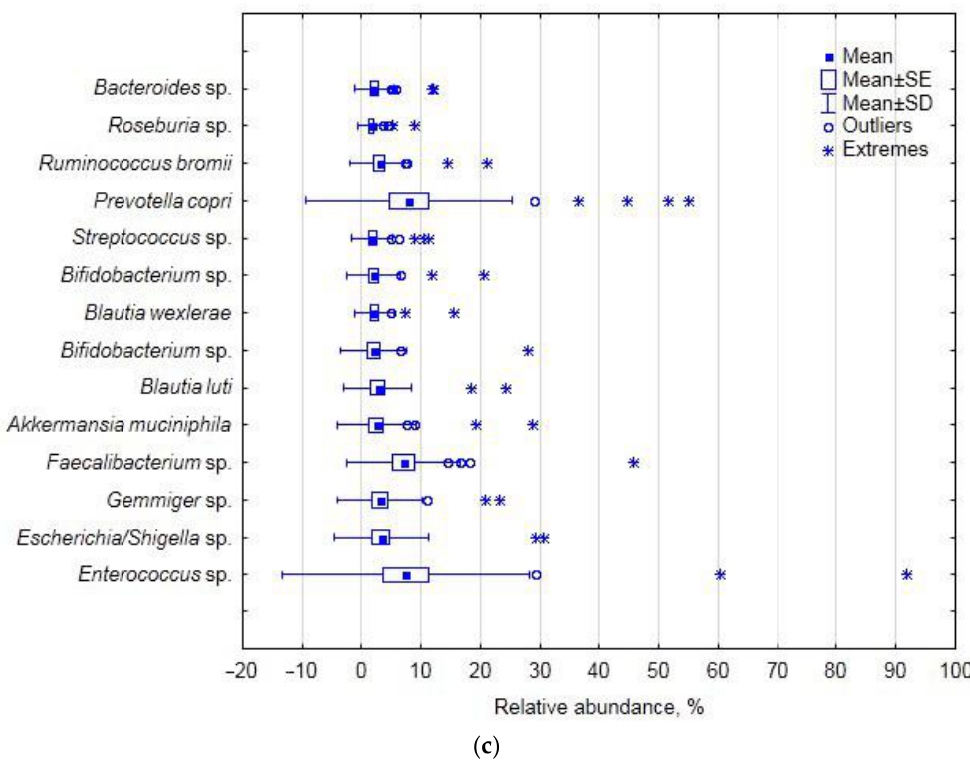
Figure 1. Relative abundance of the dominant bacterial taxa in females with gallstone disease (GSD) before cholecystectomy (CCE): ( a ) phyla, ( b ) families, ( c ) operational taxonomic units (OTUs).